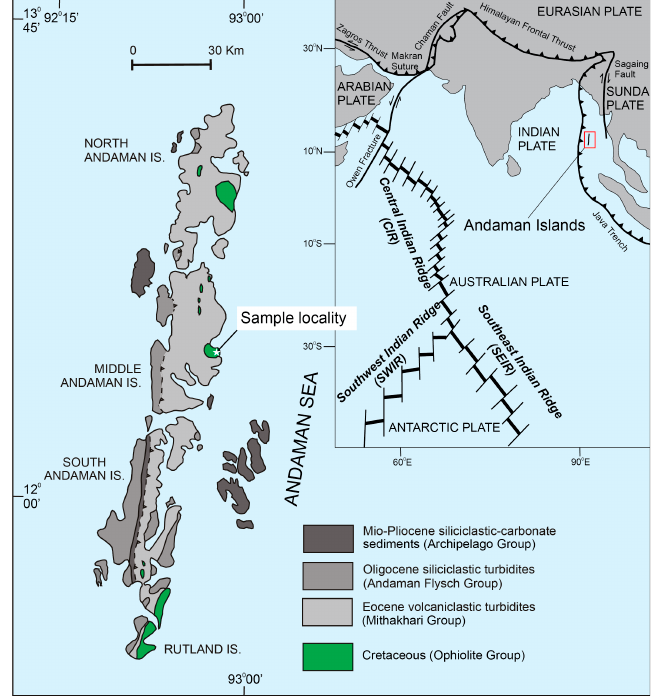
Figure 1. Geology of the Andaman Islands (simplified after [12] showing the sample localities from the Middle Andaman Ophiolites (green in color)).